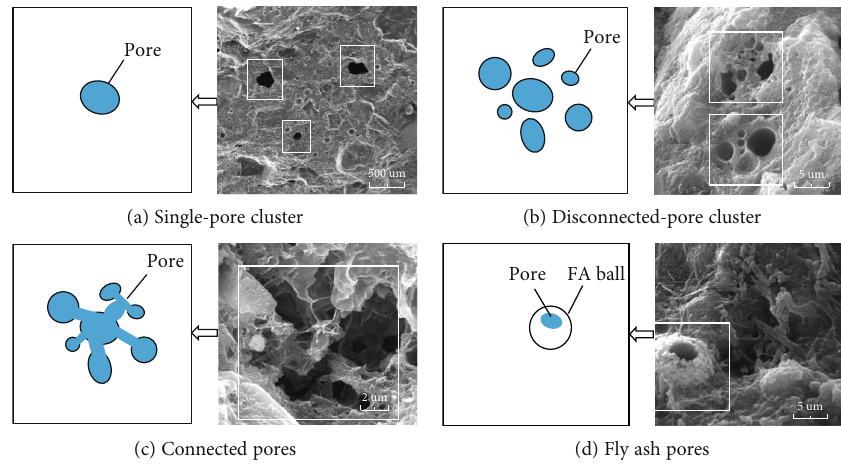
Figure 4: Pore characteristics of concrete mixed with fl y ash after freezing-thawing cycles and